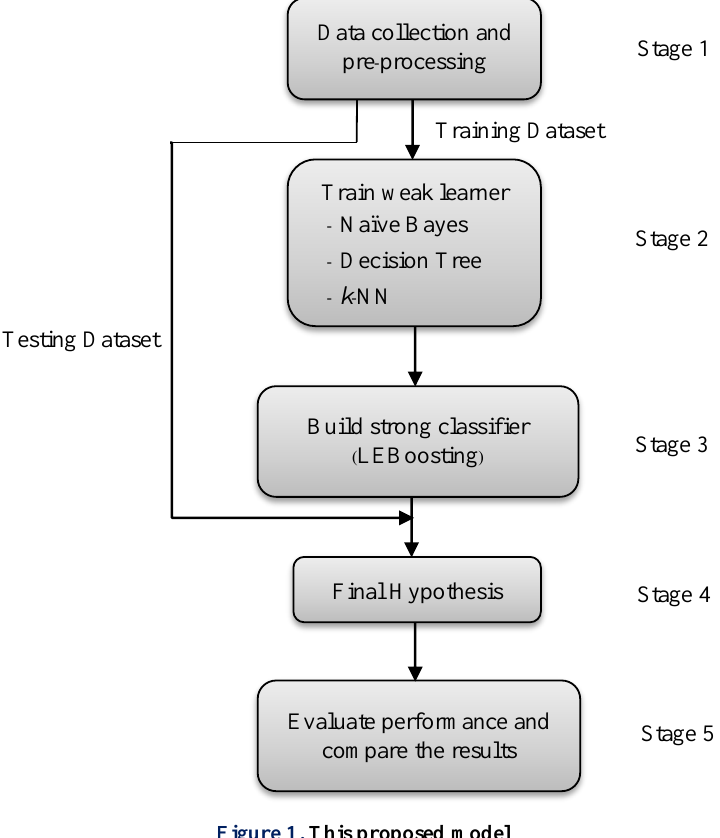
Figure 1. This proposed model